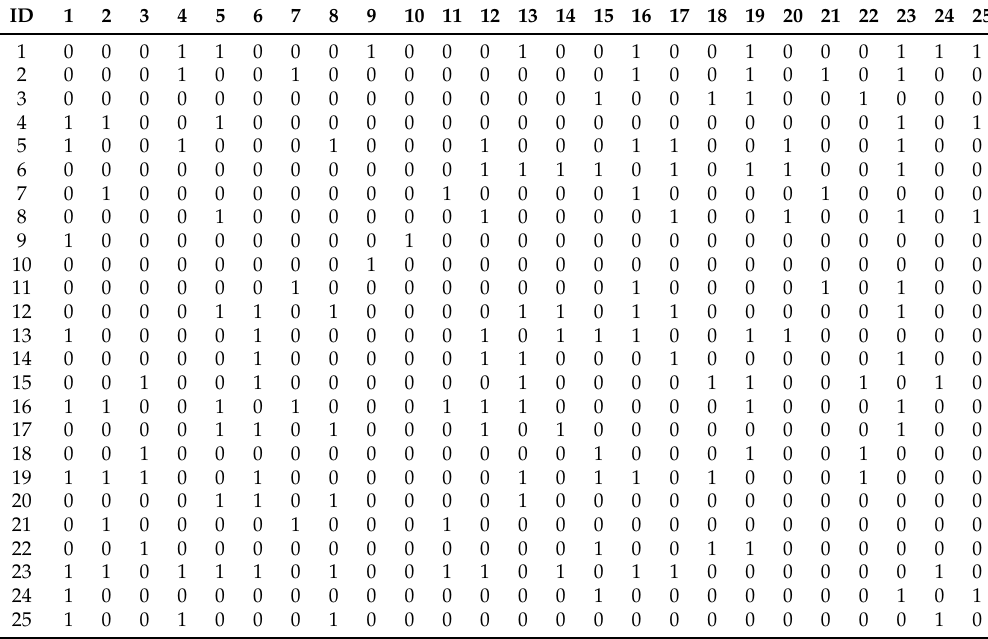
Table 4. Adjacency matrix of the selected topology